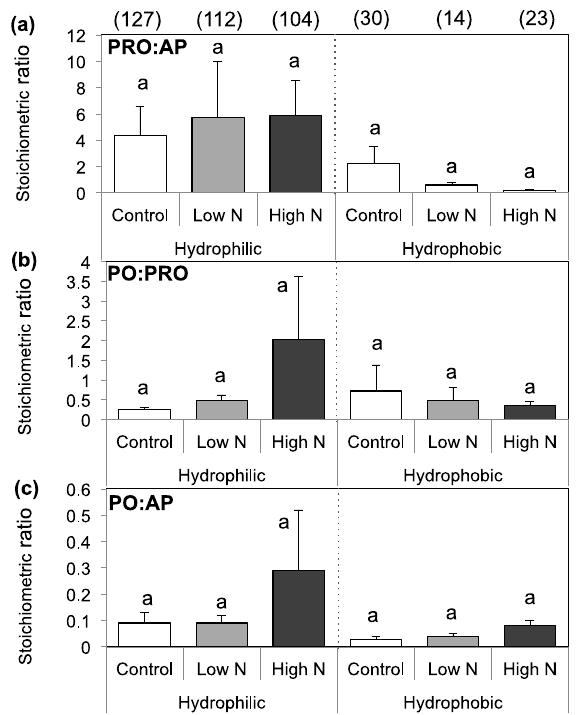
Figure 5. Mean ( a ) PRO:AP, ( b ) PO:PRO, and ( c ) PO:AP ratios based on mantle structure in control and N-fertilized plots. Mantle types with the same letter did not differ significantly at p < 0.05 based on Tukey’s HSD test. Root tip number per hydrophobicity type is listed on the top panel.